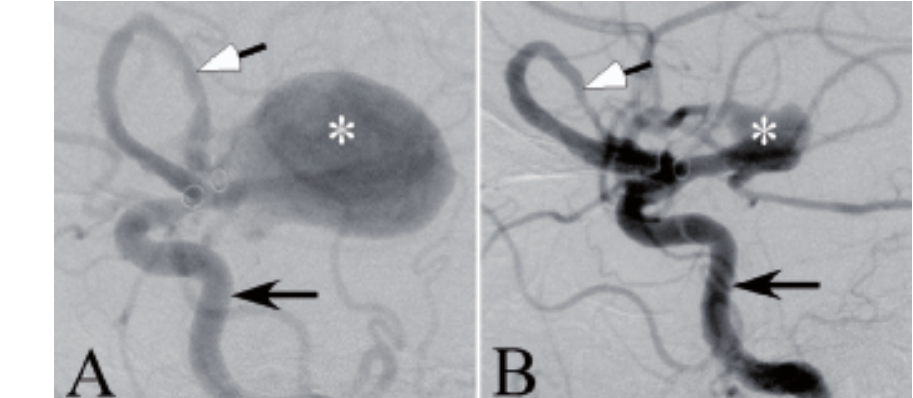
Second extra-in- tracranial bypass establishing a direct communication be- tween the external carotid artery (white arrow) at the neck and the middle cere- bral artery (dark arrow). The internal carotid artery was clipped intracranially proximal to the giant aneurysm, which totally thrombosed after the second